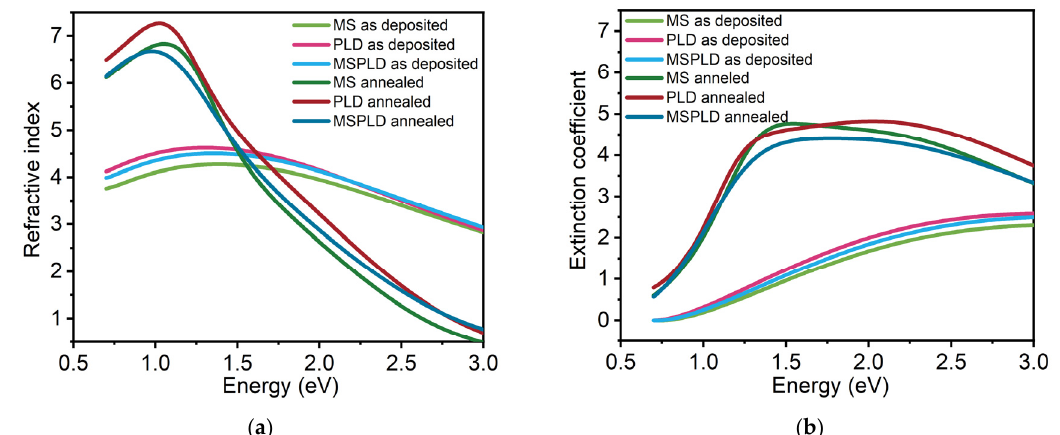
Figure 3. Comparison of optical functions of GST-225 films deposited by three deposition techniques. ( a ) Refractive index. ( b ) Extinction coefficient.